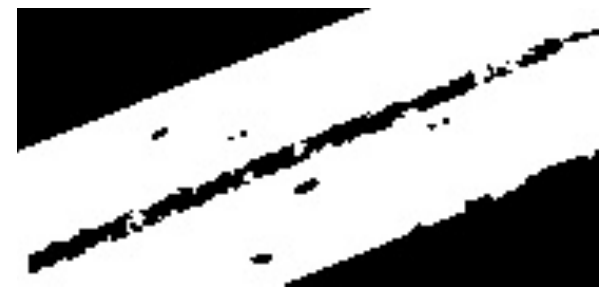
Figure 7: Result after growing seeds